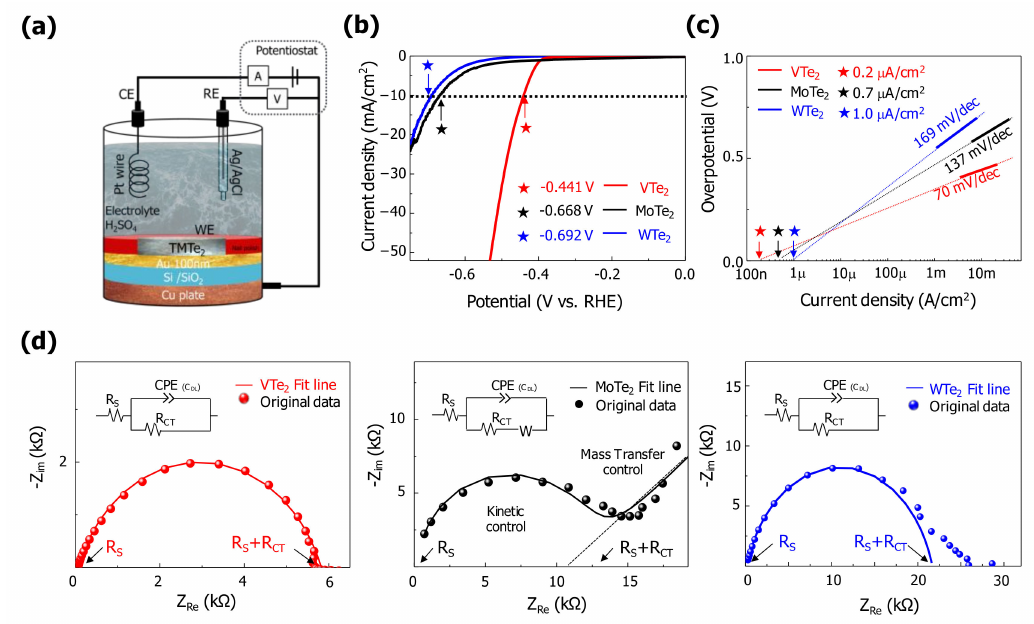
Figure 2. ( a ) Experimental set-up for electrochemical measurements of three TM Te 2 single crystals. ( b ) Linear sweep voltammetry and ( c ) Tafel plots and ( d ) the electrochemical impedance spectroscopy of three TM Te 2 with the Randles circuit, which include the series resistance (R S ), the charge transfer resistance (R CT ), and the constant phase element